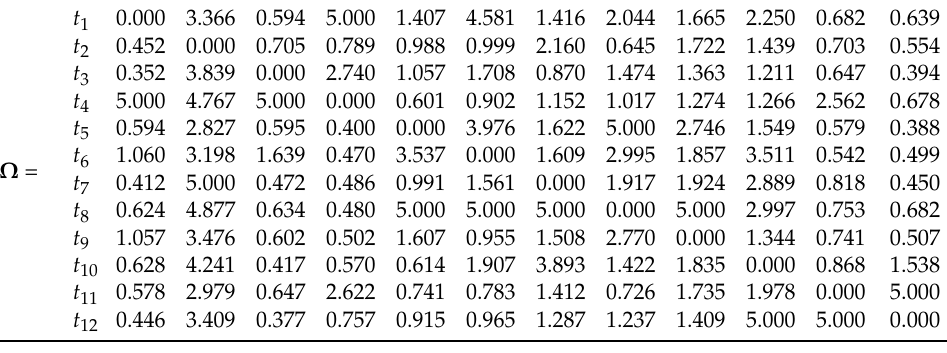
Table 5. Feature Importance Matrix M F